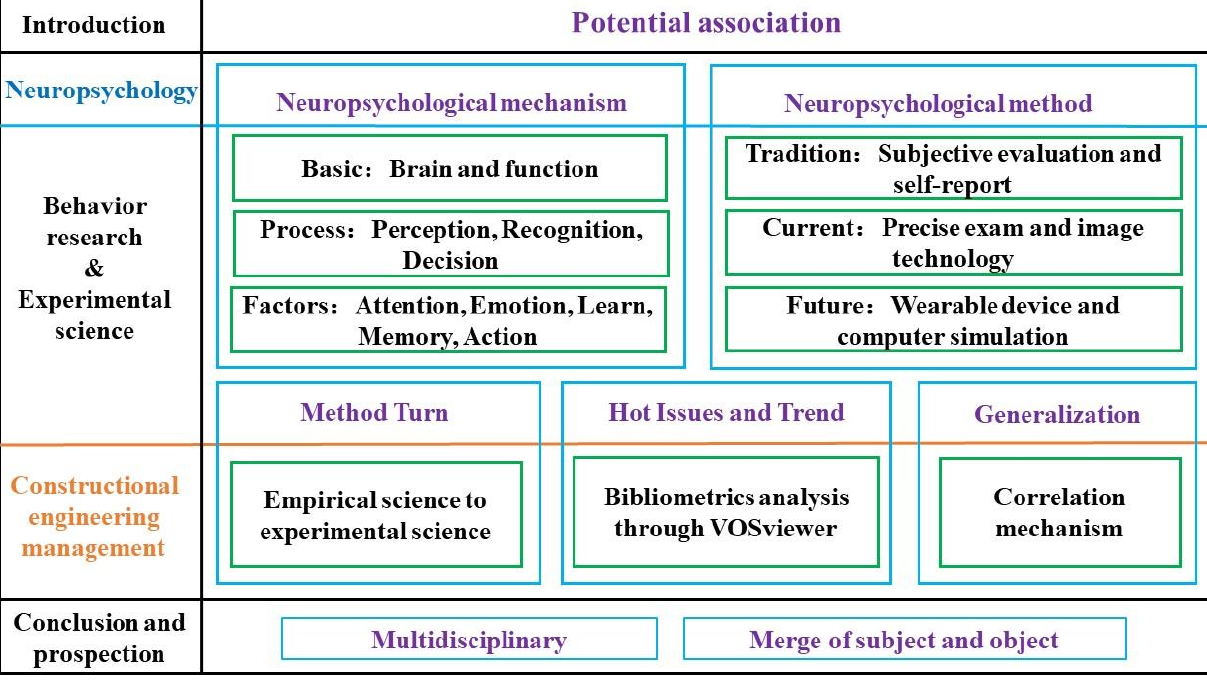
Figure 1. Research framework.